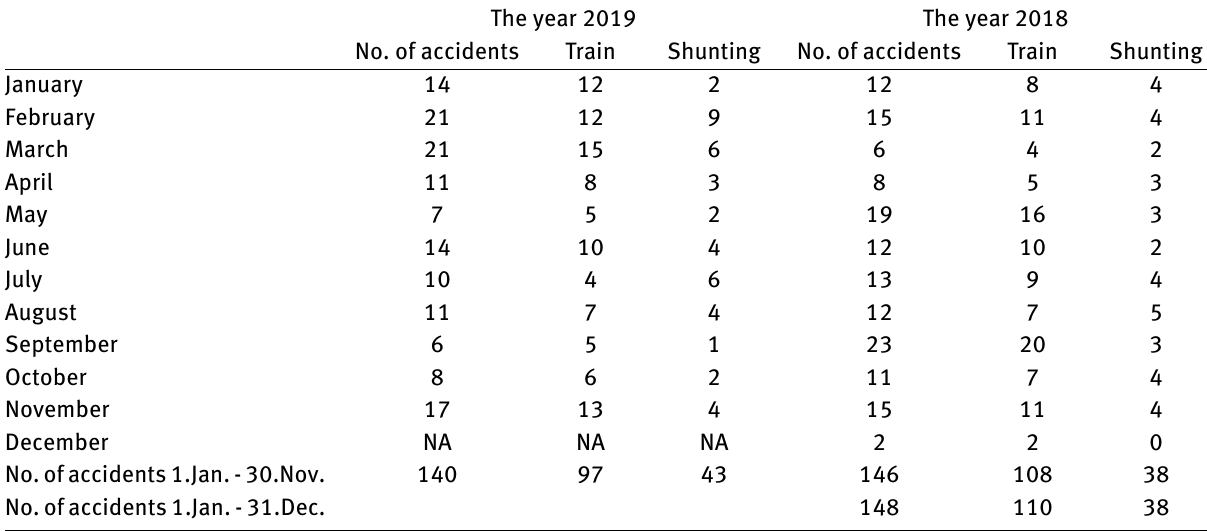
Table 1: Unauthorized driving across signalling prohibitions, including subsequent collision or derailment on national lines, regional lines and sidings (Source: Czech Rail Safety Inspection Oflce,